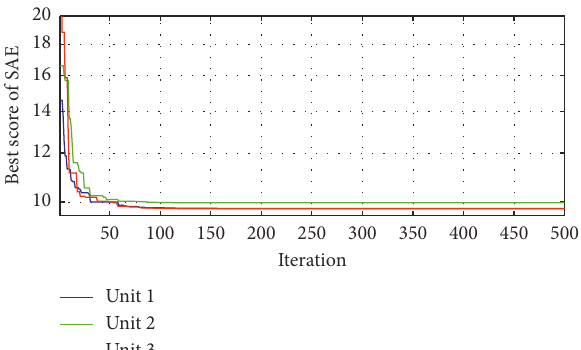
Figure 7: SAE convergence for model 2.